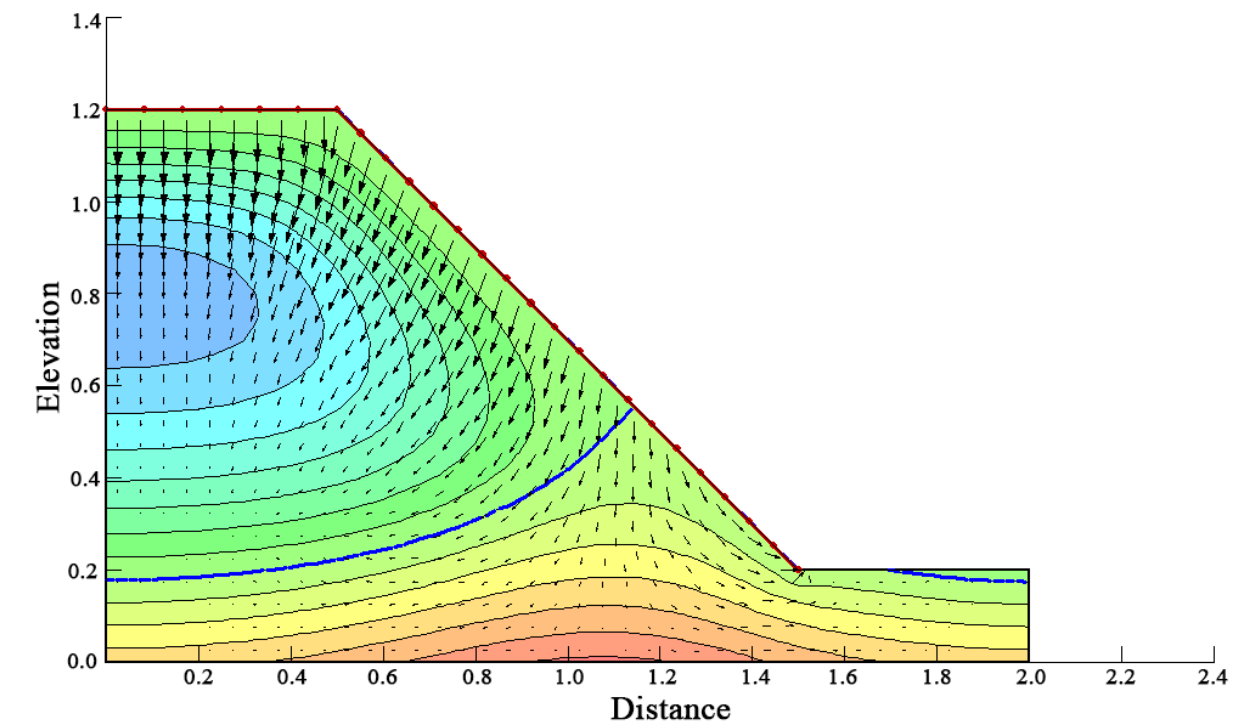
Figure 10. Changes of the slope phreatic line and seepage field after 2 h of rainwater infiltration. The seepage in the slope after 2 h at 36 mm/h is shown in Figure 10. All arrows are distributed in the interior of the slope, and the arrows decrease in size from the slope surface to the center. The arrow density in Figure 10 is greater than that in Figure 9. The water head gradually dropped from the left side of slope to the right, the width of the water head equipotential line decreased gradually, the width of the slope center in Figure 9 is smaller than that in Figure 10, and the arrows are nearly parallel with the surface of the slope and the base of slope below the phreatic line. The location of the phreatic line was 36 mm/h on the surface of a slope that was approximately 0.5 m. The location of the maximum water head at 36 mm/h was below the phreatic line, and the location of the